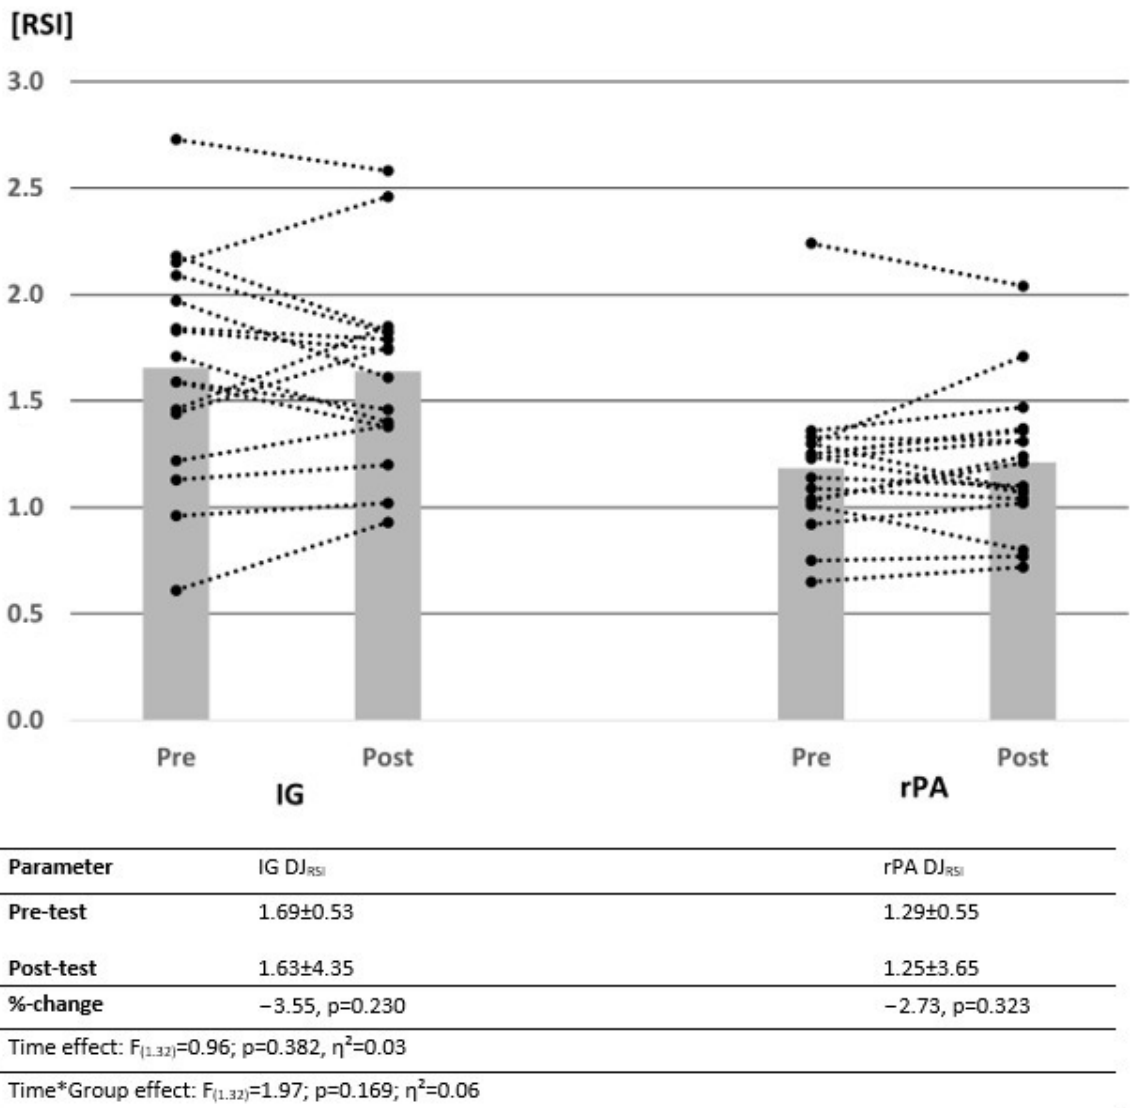
Figure 6. Change in mean values and individual cases of reactive strength index of control and intervention groups over time. Data presented as means ± SD. IG = intervention group, CG = control group, DJ RSI = reactive strength index. Table 3. Provides descriptive statistics, percentage increases, and time effect and time × group interaction effects for DJ height and contact time. Data presented as means ± SD.